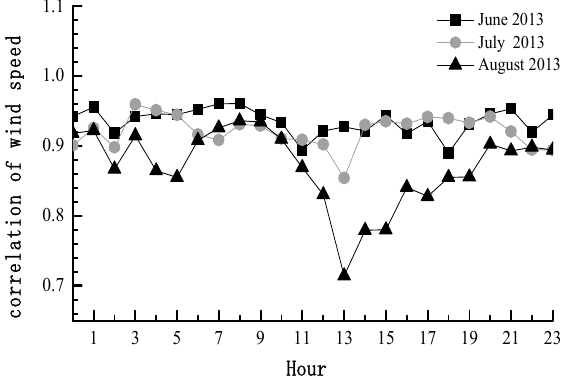
Figure 7. Statistical curve of WSC coefficient in different hours.